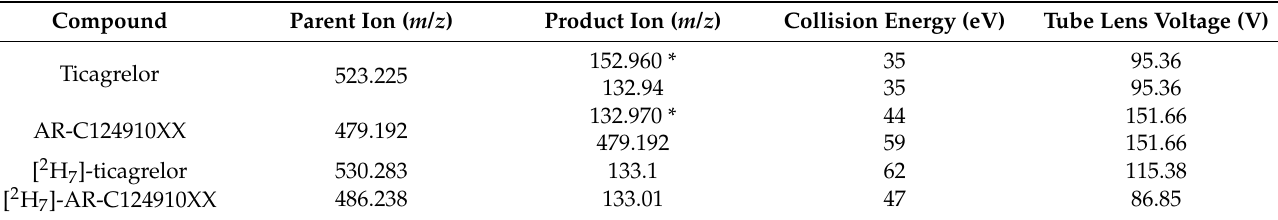
Table 3. Mass spectrometry operating conditions for our compounds. Transitions ( m / z ) used for quantification are labeled *. Compound Parent Ion ( m / z ) Product Ion ( m / z ) Collision Energy (eV) Tube Lens Voltage (V) 152.960 * 35 95.36 Ticagrelor 523.225 132.94 95.36 AR-C124910XX